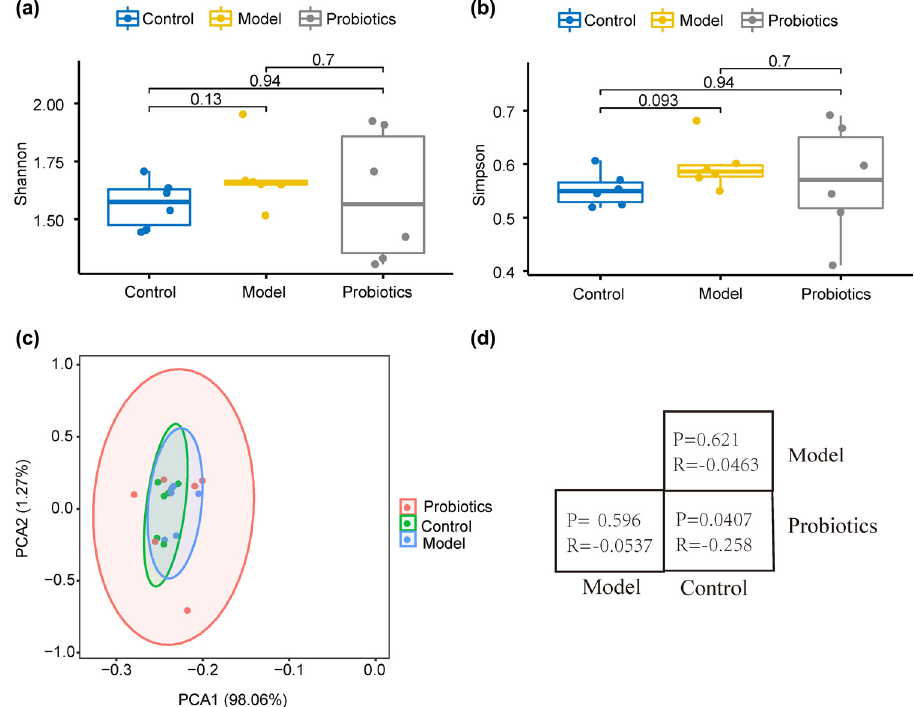
Figure 2: Microbial structure di ff erences. ( a ) Shannon index of the control group, the model group, and the probiotic group. ( b ) Simpson index of the control group, the model group, and the probiotic group. ( c ) PCA of the control group, the model group, and the probiotic group. ( d ) Calculate P values and R values between groups; a P value indicated whether there is a statistical di ff erence between the groups, and R ( v3.3.2 ) was used to analyze α diversity and β diversity. P value of < 0.05 was considered statistically signi fi